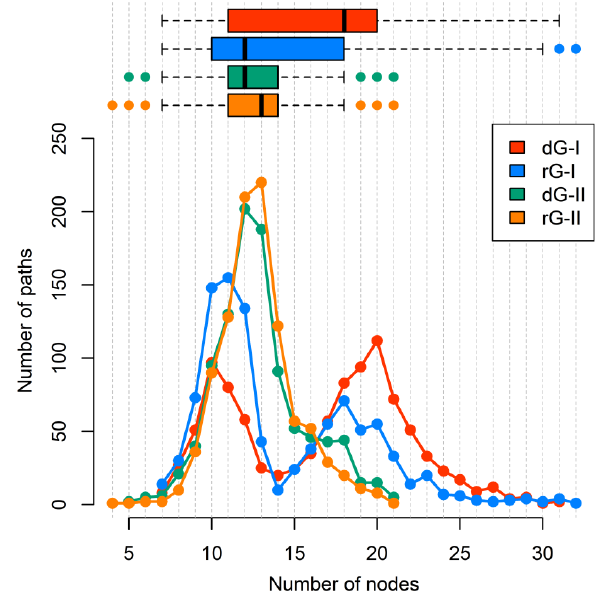
Figure 9. The number of nodes per path connecting A30(G21) and C39(A31) residues of 2′-dG-I and 2′-dG-II riboswitches classes bound to dG and rG. Each system was colored according to the figure caption.